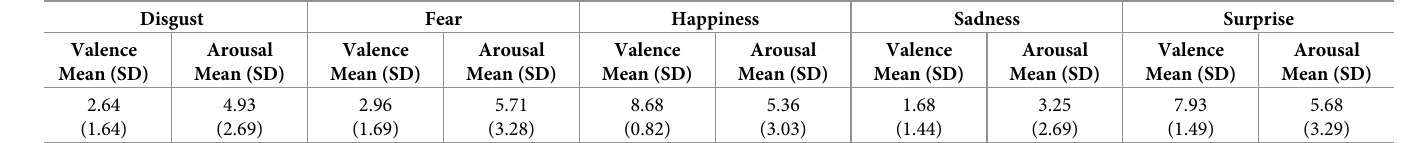
Table 1. Means and standard deviations (SD) of SAM performed by 28 children.